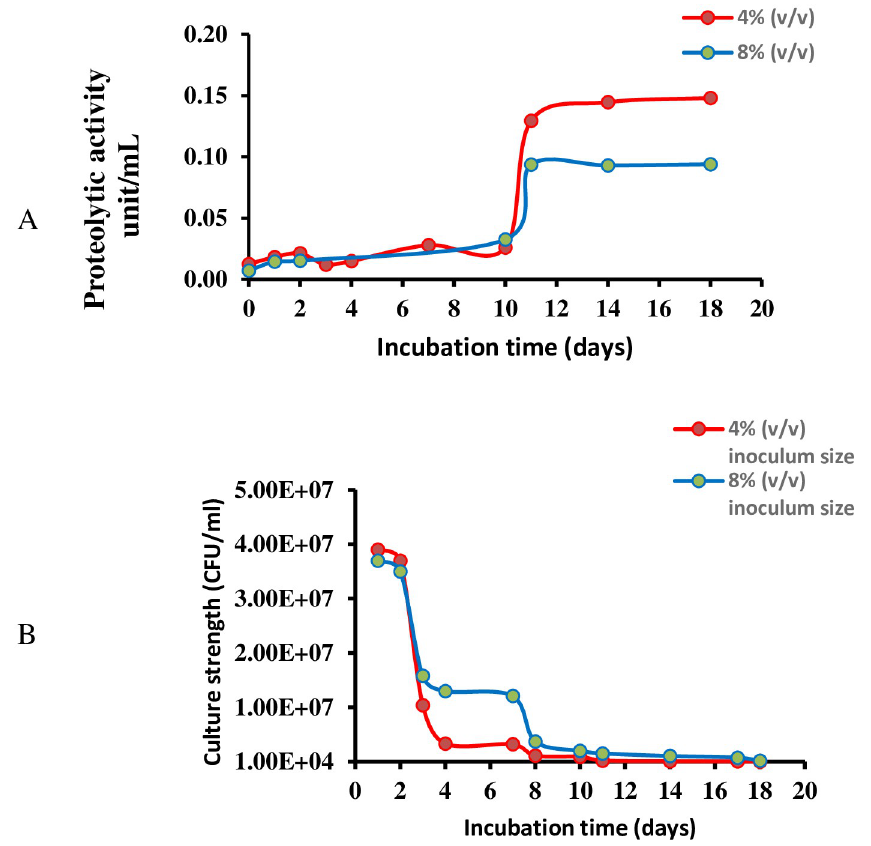
Fig 1. Effect of incubation time and bacterial density on L . enzymogenes proteolytic activity. A ; Effect of culture density (PA, 4% (v/v) and PB, 8% (v/v)) B ; Effect of incubation time